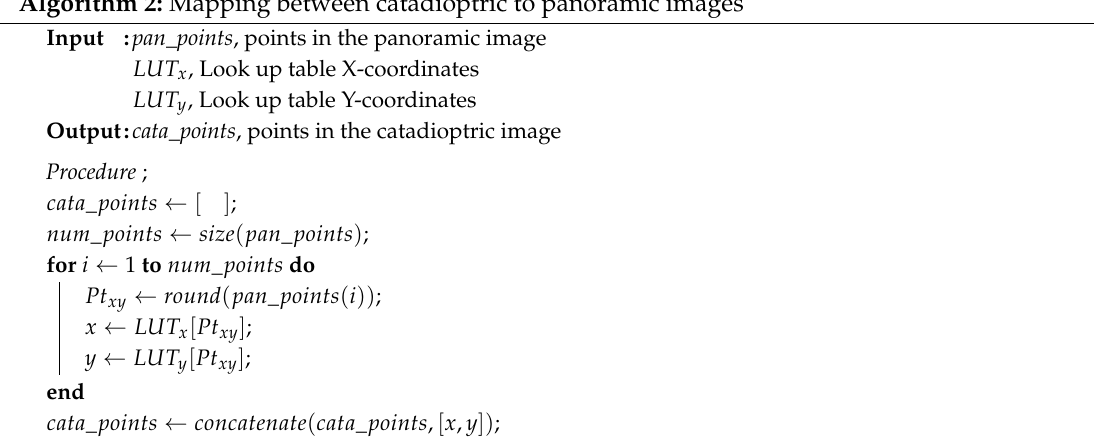
Algorithm 2: Mapping between catadioptric to panoramic images Input : pan_points , points in the panoramic